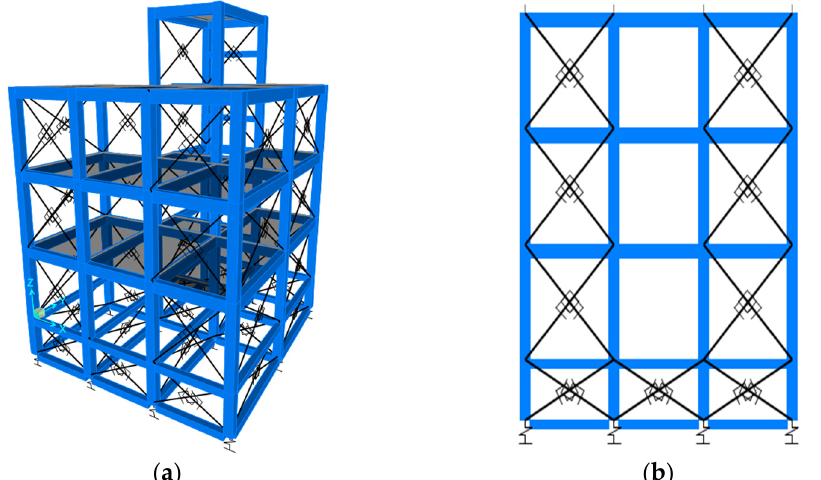
Figure 8. ( a ) 3D model for infill considering soil–structure interaction scenario, ( b ) 2D elevation of infill considering soil–structure interaction along Grid-1. Table 2. Features of finite element